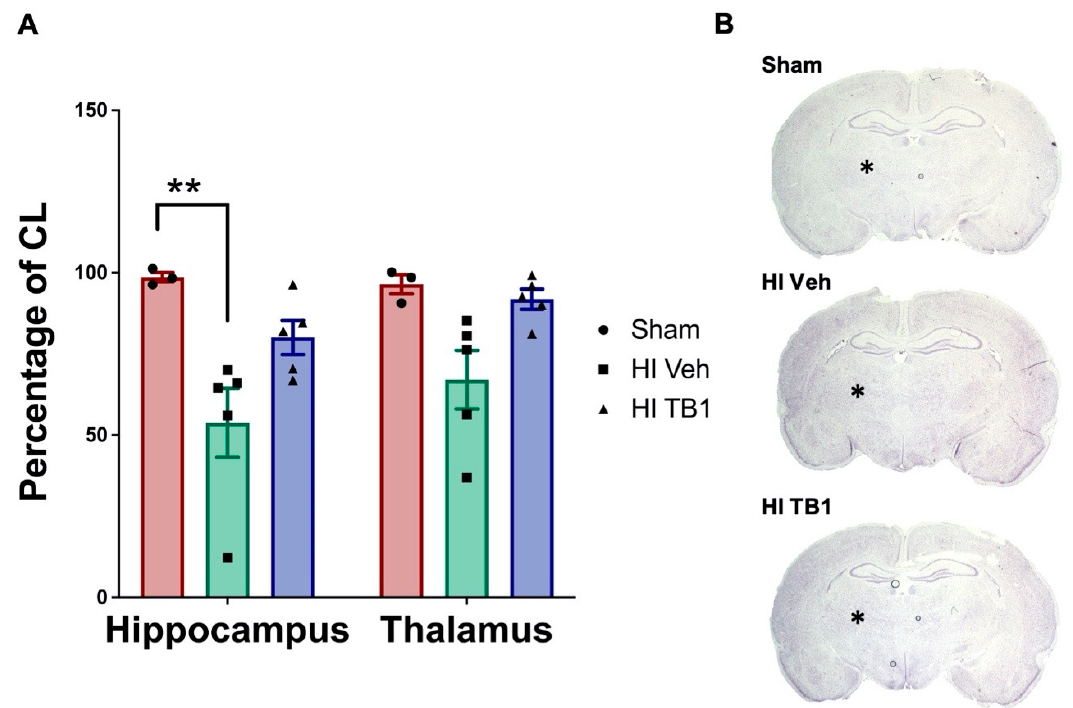
Figure 5. Systemically administered Tat-Beclin1 reduced hippocampal and thalamic neurodegeneration after HI injury. Cresyl Violet stained sections at +3 mm from Bregma were analyzed two weeks after HI injury at P6. ( A ) Areas of the hippocampus and thalamus were measured and normalized to contralateral structures. ( B ) Representative images of structural loss of hippocampal (enclosed by dashed line) and thalamic regions as compared to the contralateral hemisphere n = 3 for Sham group; n = 5 per HI groups. Data are presented as means ± SEM, ** p < 0.001 by one-way ANOVA followed by Tukey’s multiple comparison test.